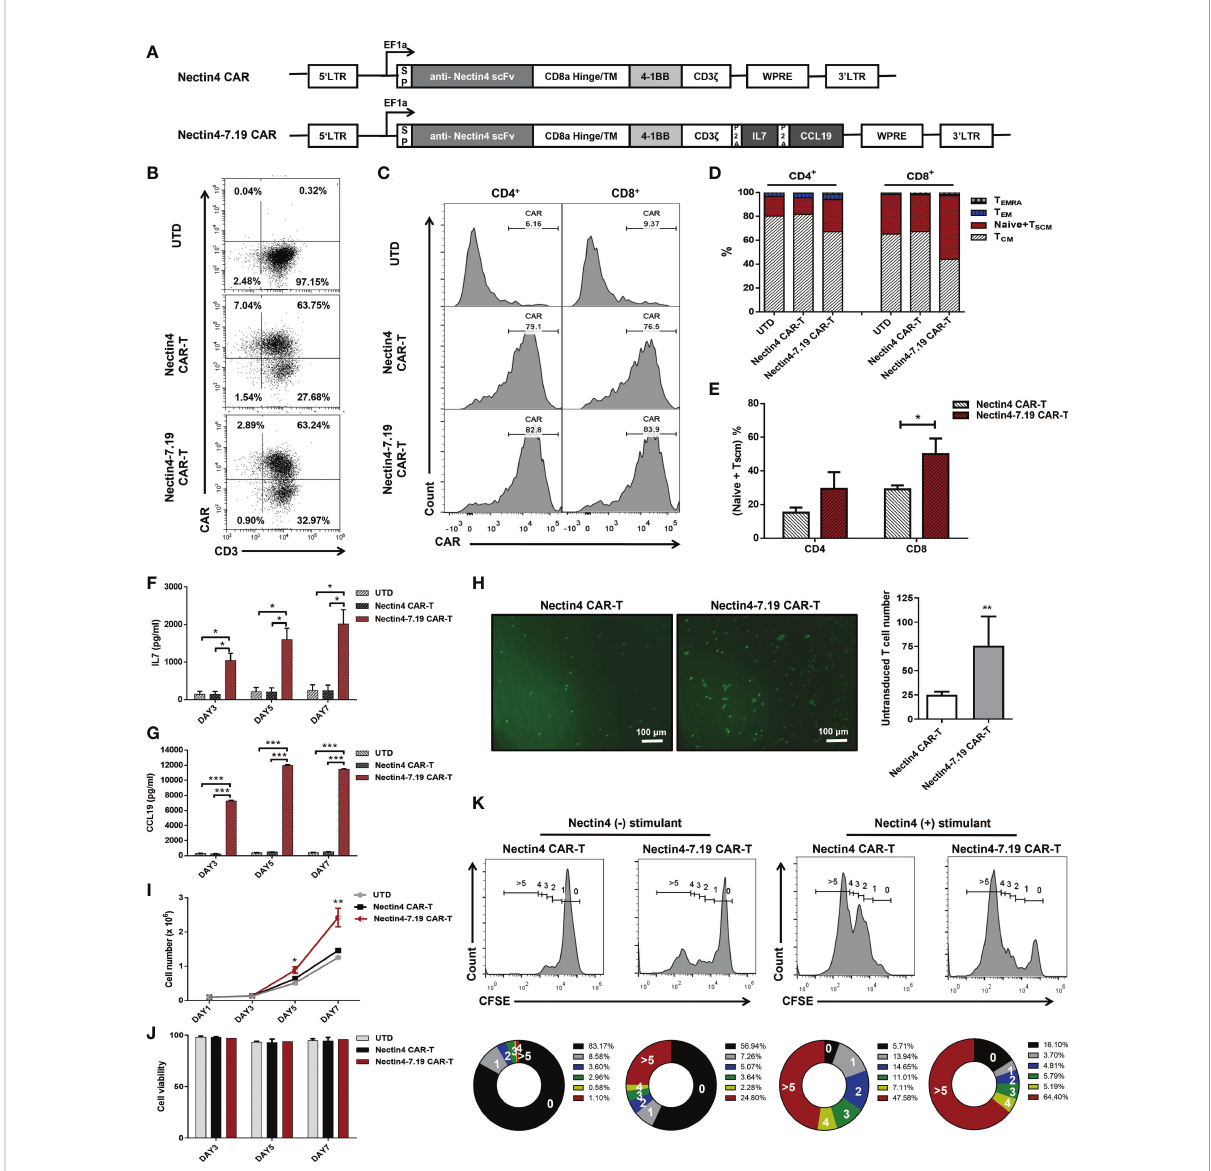
FIGURE 2 CAR structure and characterization of Nectin4-7.19 CAR-T cells. (A) Schematic illustration of Nectin4 CAR and Nectin4-7.19 CAR lentiviral vector. LTR: long terminal repeats; SP: CD8 signal peptide; TM: transmembrane region; P2A: 2A polypeptide element. (B) CAR expression in Nectin4 CAR-T and Nectin4-7.19 CAR-T cells was measured by fl ow cytometry. UTD indicates the untransduced T cells as a negative control. (C) Relative CAR expression in CD4 + and CD8 + T subsets. (D) Representative CAR-T cell phenotyping plot based on CD45RA and CCR7 in CD4 + and CD8 + T subsets. T memory stem cell, T SCM (CD45RO + CD45RA + CCR7 + ); Naïve (CD45RO - CD45RA + CCR7 + ); central memory T cell, T CM (CD45RO + CD45RA - CCR7 + ); effector memory T cell, T EM (CD45RO + CD45RA - CCR7 - ); terminally differentiated effector memory T cell, T EMRA (CD45RO + CD45RA + CCR7 - ). (E) Proportion of (Naïve + T SCM ) subpopulation in CD4 + and CD8 + T subsets. (F, G) Secretion of IL-7 (F) and CCL19 (G) was examined by ELISA. (H) Transwell assays were performed to detect the chemotactic capacity of CFSE-labeled T cells after incubation with culture supernatant from Nectin4 CAR-T or Nectin4-7.19 CAR-T cells. Representative pictures (left panel) and statistical analysis diagram (right panel) are illustrated; scale bar = 100 m m. (I, J) Proliferative capacity (I) and viability (J) of Nectin4 CAR-T and Nectin4-7.19 CAR-T cells were tested by counting. (K) Epitope-driven proliferation for a comparison in Nectin4 CAR-T and Nectin4-7.19 CAR-T cells. Nectin4 CAR-T and Nectin4-7.19 CAR-T cells were labeled with CellTrace ™ CFSE and co-cultured with ABC-1 cells (Nectin4 + stimulant) or 293T cells (Nectin4 − stimulant) for 5 days in the absence of exogenous cytokines. The numbers of cell divisions are indicated in the histograms. The numbers in the donut charts represent percentages of each gated fraction in the cultured cells (0, black; 1, gray; 2, blue; 3, green; 4, yellow; and >5, red). Data represent the mean ± SD of three independent experiments; * p < 0.05, ** p < 0.01, *** p < 0.001, t